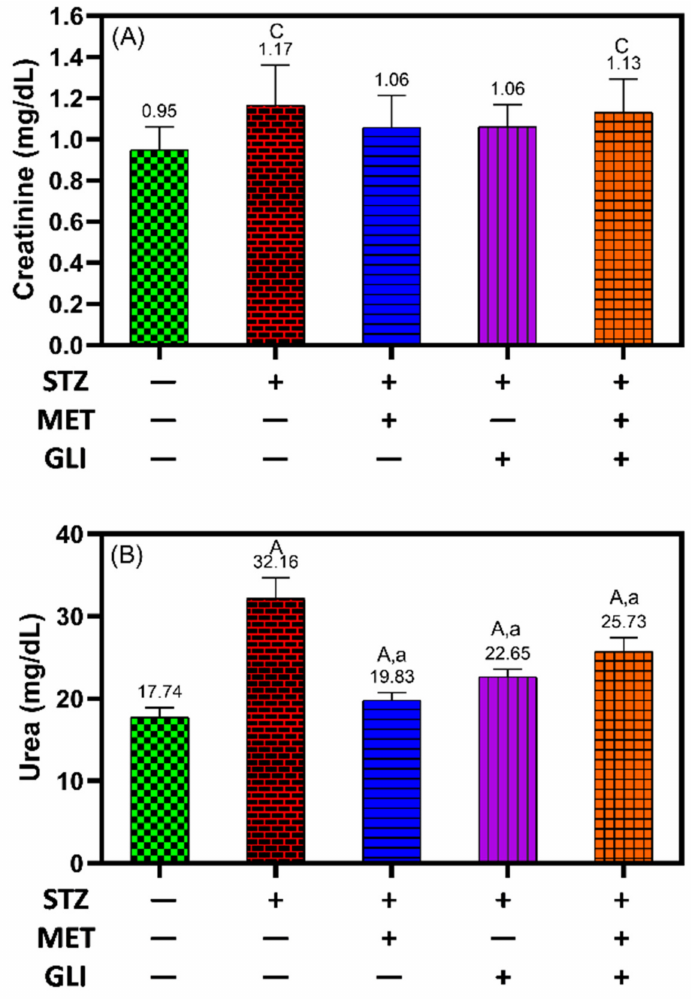
Figure 4. Effects of metformin, glipizide, and their combination on kidney function tests ( A ) creatinine and ( B ) urea in diabetic rats. Each data is expressed as the Mean ± SD. A, B and C notation (in capital letters) indicate the significant difference levels p < 0.001, p < 0.01, and p < 0.05 between studied groups and healthy controls, respectively. While a, b, and c notation (in small letters) indicate the significant difference levels p < 0.001, p < 0.01, and p < 0.05 between studied groups and untreated DM groups,